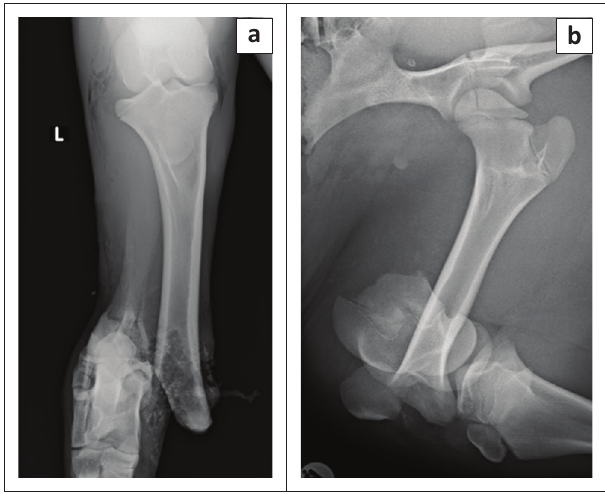
FIGURE 1: Radiographs of the pelvic limbs of a 4-month-old wildebeest ( Connochaetes taurinus ) showing complete fractures to the (a) left tibia and (b) right femur sustained in a motor vehicle accident. TABLE 1: Physiological and blood gas parameters for an anaesthetised blue wildebeest ( Connochaetes taurinus ) calf undergoing isoflurane-in-oxygen anaesthesia for repair of bilateral pelvic limb fractures.